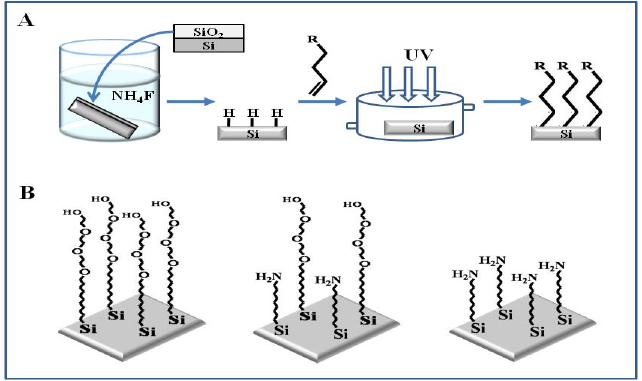
Figure 2. (A) Covalent modification of silicon. (B) The resulting monolayers of 100% EG3-ene, 50% Boc- N -ene + 50% EG3-ene, and 100% Boc- N -ene. Reproduced with permission of ACS